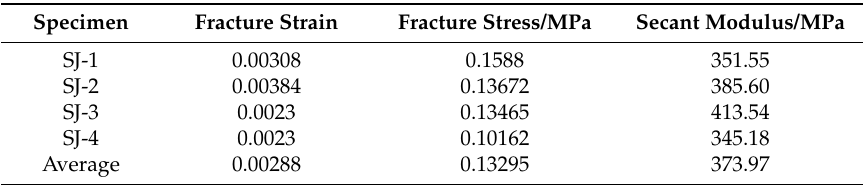
Table 8. HMAC parameters of monotone direct tensile test.